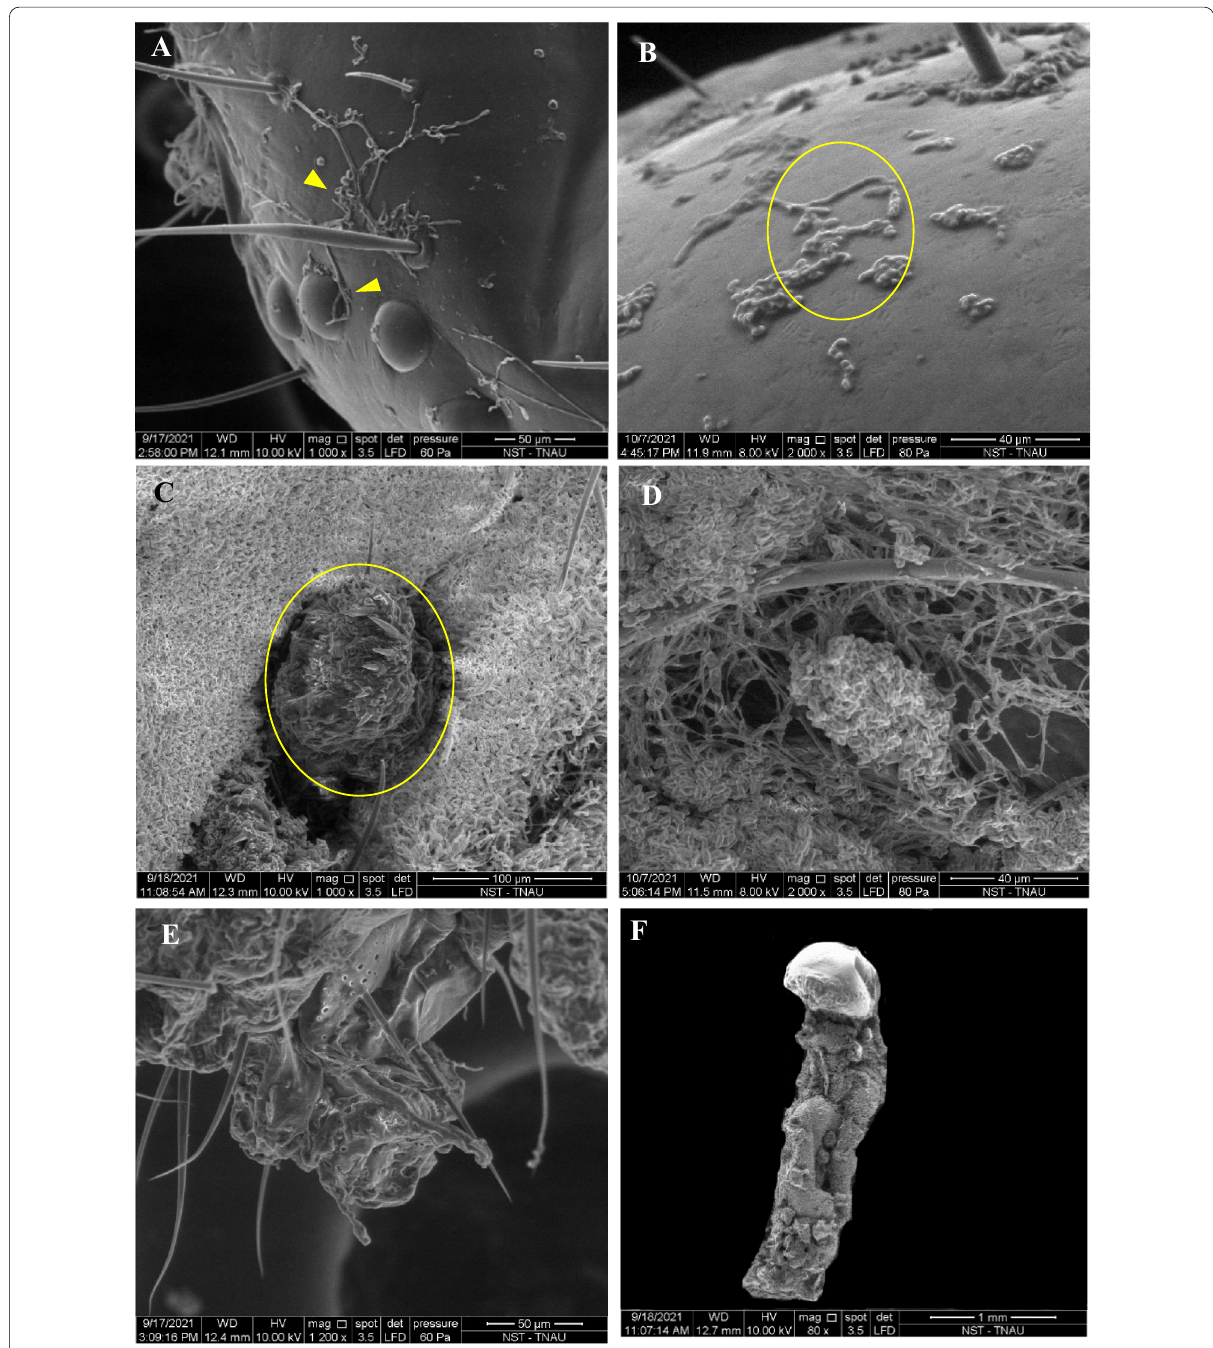
Fig. 8 SEM images of second instar of Spodoptera frugiperda infected with Metarhizium anisopliae (168 hpi). a . Close-up of seta socket and stemmata with hypha and conidia (arrowheads). b . Extruding hypha with conidia in head region (circle). c . Extensive growth of hypha around prolegs (circle). d . Close-up of mycelial threads with conidia in abdominal region. e . Thoracic leg completely covered by fungal mycelial network. f . Full view of mummified